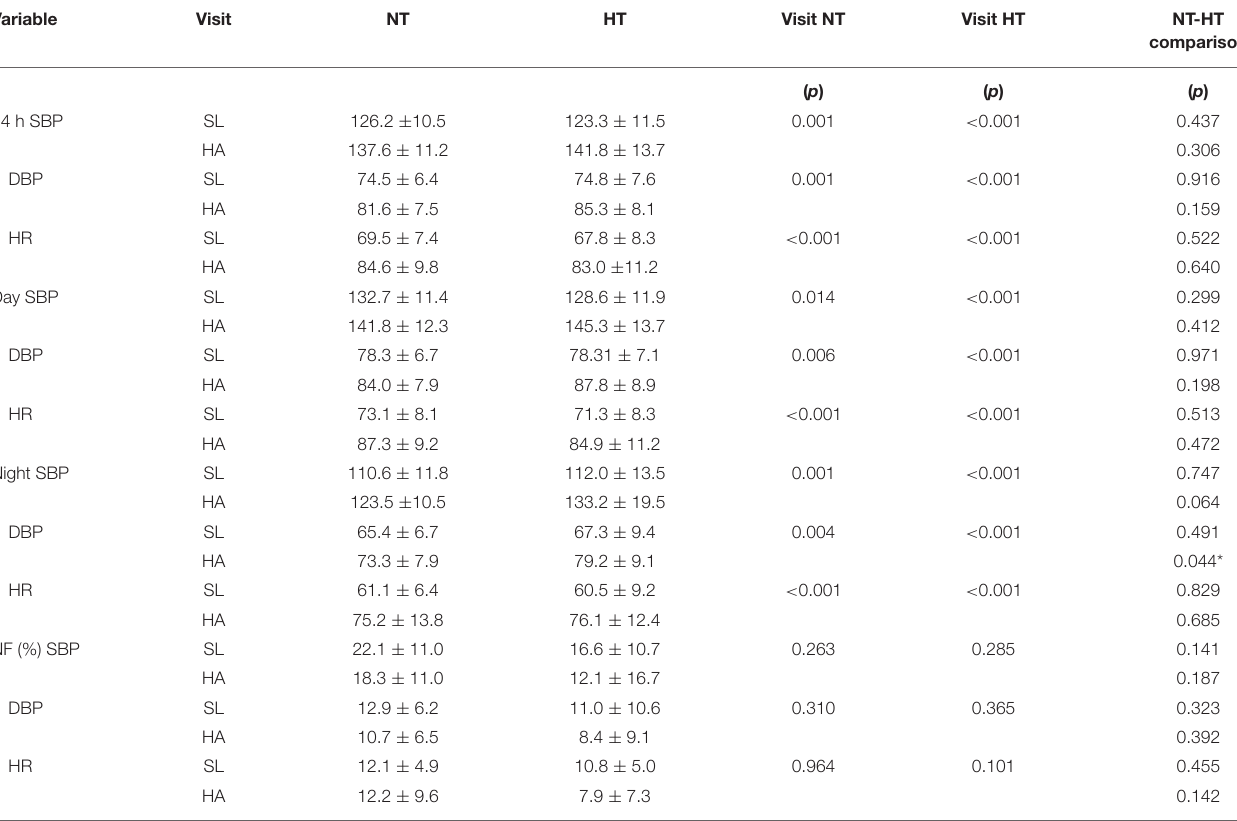
TABLE 4 | Mean 24-h, daytime, nighttime, dipping and work SBP, DBP, and HR at SL and HA by groups (NT and HT). Variable Visit NT HT Visit NT Visit HT NT-HT